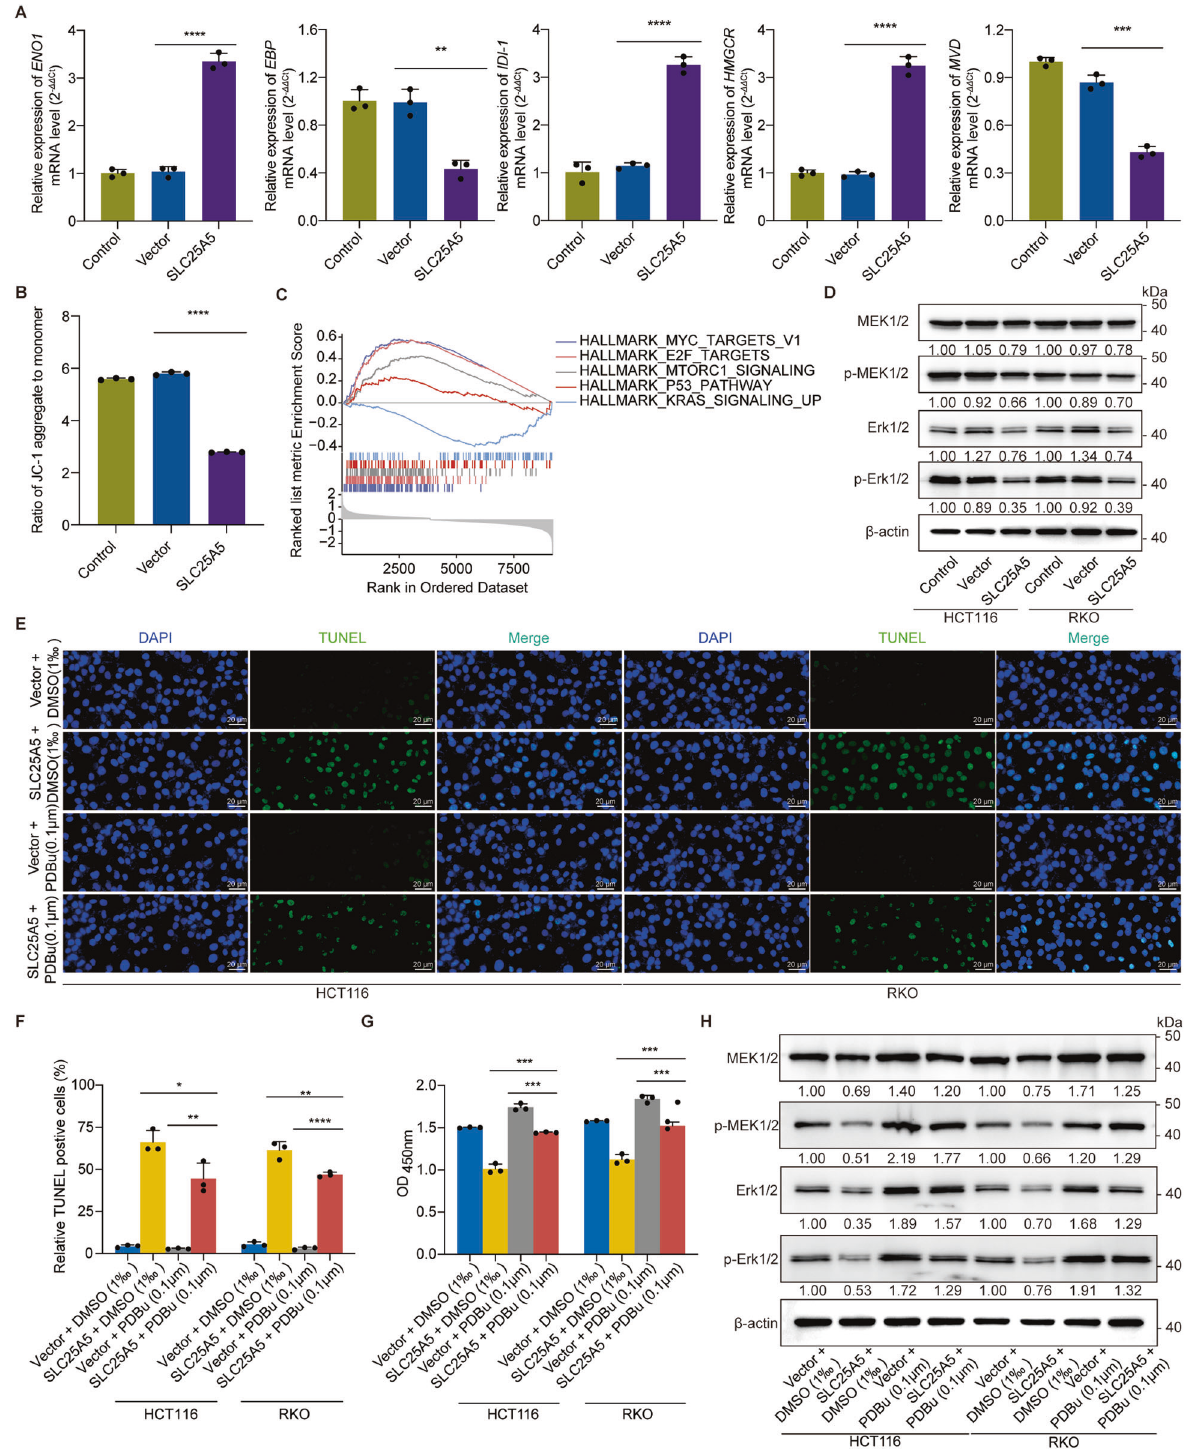
Fig. 8 SLC25A5 was involved in mitochondrial metabolism and activity, while it exerted an effect on tumorigenesis via the MAPK signaling pathway. A The expression of ENO-1, IDI-1, and HMGCR was upregulated, while EBP and MVD were downregulated when SLC25A5 was overexpressed. B Decreased mitochondrial membrane potential was determined by JC-1 staining, suggesting the inhibition of mitochondrial activity. C GSEA hinted that high expression of SLC25A5 was negatively related to the KRAS signaling pathway. D Protein levels of MEK1/2, pMEK1/2, Erk1/2, and p-Erk1/2 were detected by western blotting. E Representative images of TUNEL staining in cells in the presence of the MAPK activator PDBu (0.1 μ g for 24 h) or dimethyl sulfoxide (DMSO, 0.1 ‰ ) served as controls. with or without SLC25A5 overexpression. F Quantitative results of the TUNEL assay. G CCK8 assays for SLC25A5-overexpressing cells with or without 0.1 μ g PDBu treatment. H Western blot analysis of MEK1/2, pMEK1/2, Erk1/2, and p-Erk1/2 in SLC25A5-overexpressing cells with or without 0.1 μ g PDBu treatment. β -actin protein was used as the internal control. n = 3 biological replicates. Scale bar = 20 μ m. Statistical analysis: Student ’ s t test. * p < 0.05, ** p < 0.01, *** p < 0.001, **** p <